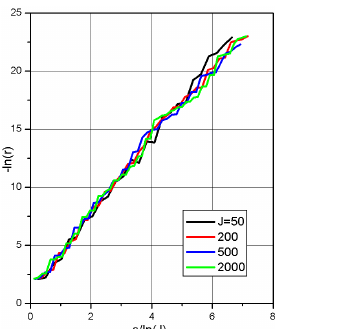
in Section 11. Figures 5–7 show graphics of function − ln( r ) in dependence on s/ ln( J ), and Figure 8 shows graphics of function − ln( d ) in dependence on s/ ln( J ).